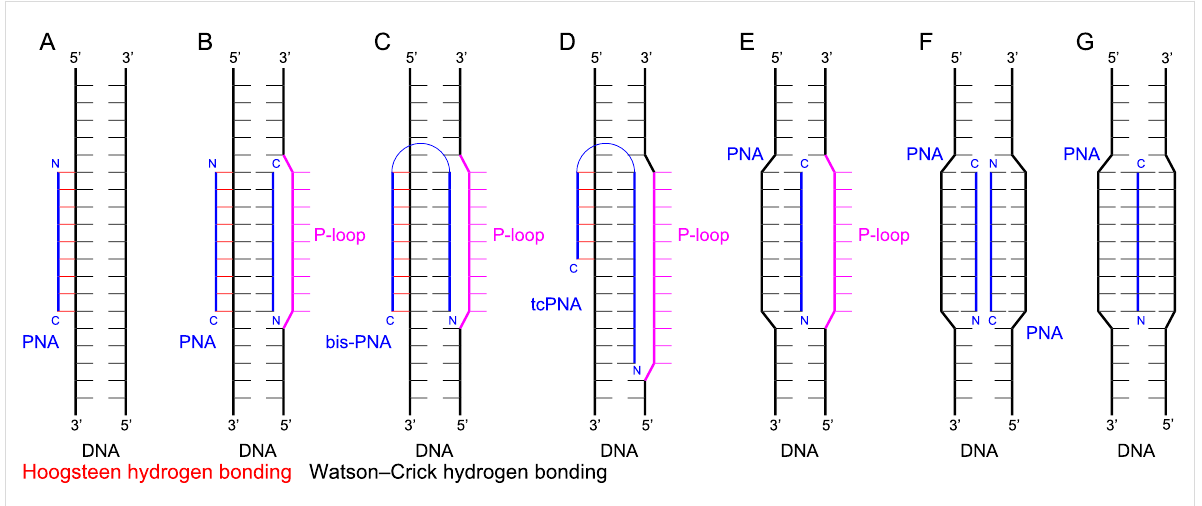
Figure 2: PNA binding modes: (A) PNA–dsDNA 1:1 triplex; (B) PNA–DNA–PNA strand-invasion triplex; (C) the Hoogsteen and Watson–Crick parts are linked together in a bis-PNA; (D) shortening the Hoogsteen part and extending the Watson–Crick part of the bis-PNA creates a tail-clamp PNA (tcPNA); (E) and (F) single and double invasion using only Watson–Crick hydrogen bonding; (G) Janus-wedge triple helix.